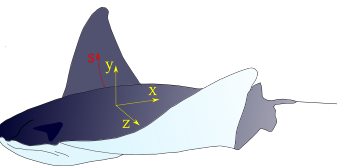
Figure 3. Reference system on the